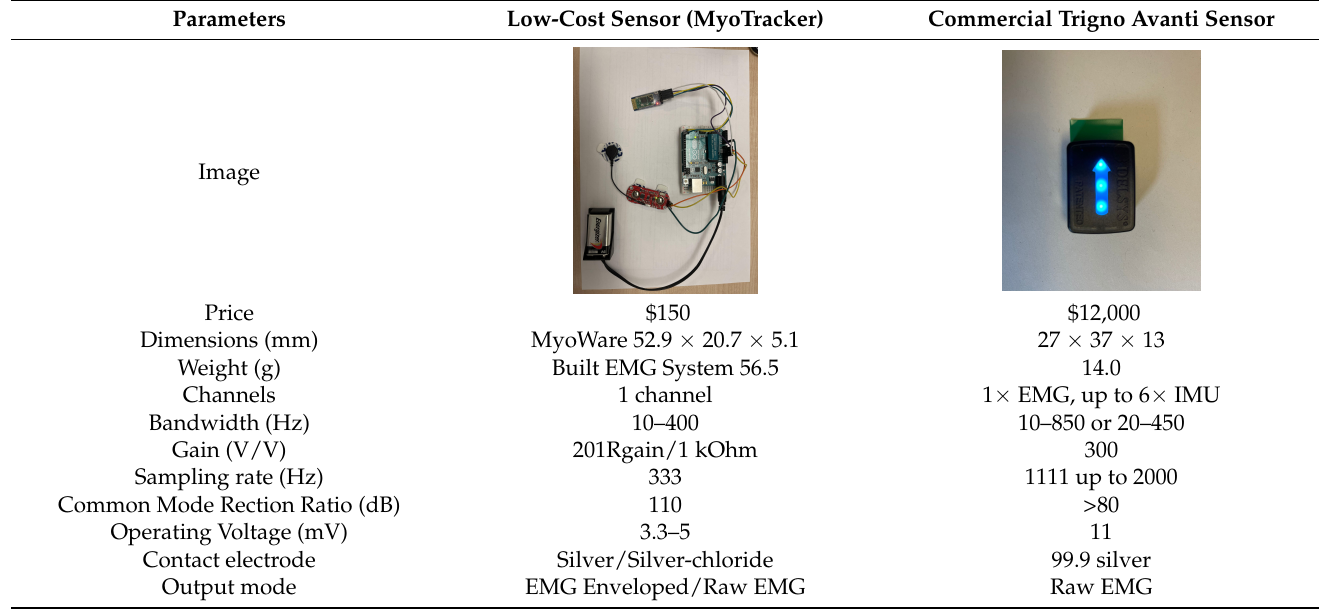
Table 2. Technical specification of the two